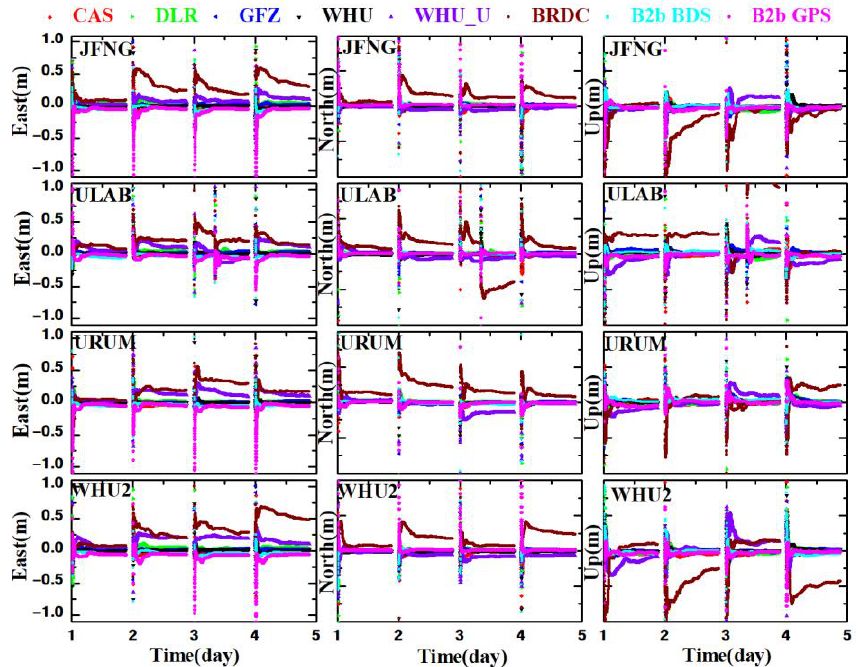
Figure 6. Error series of the four-day IF static PPP solution.